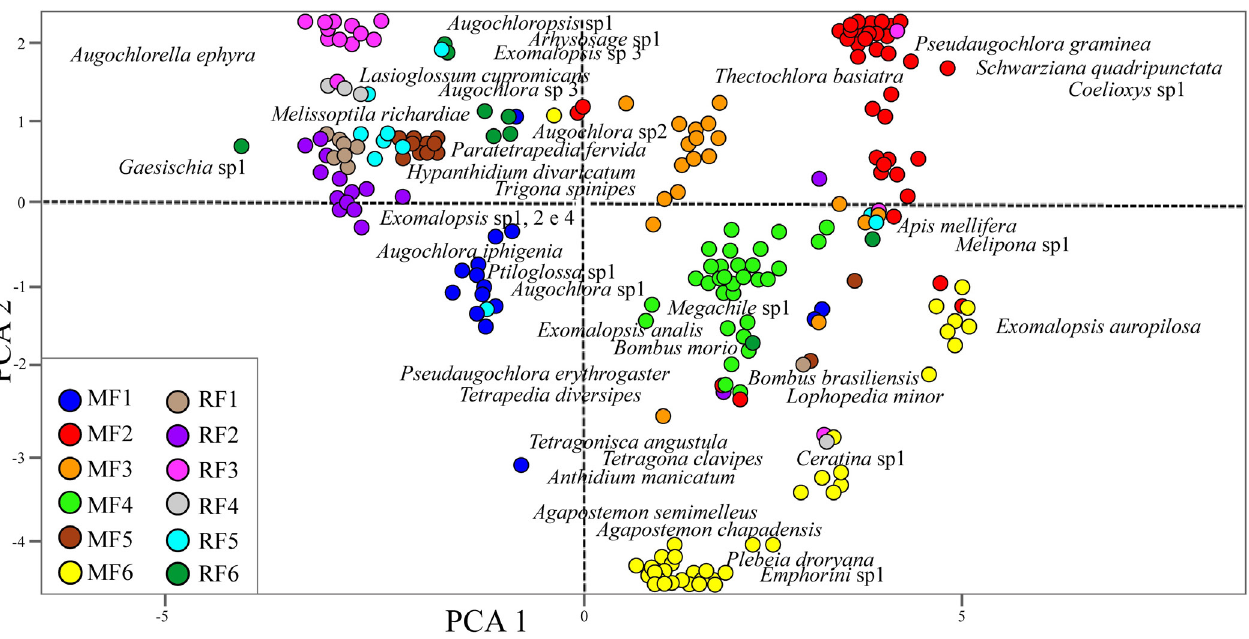
Fig 4 . Principal Component Analysis (PCA) of the bee communities at the sites (12) located in the mature (MF1, MF2, MF3, MF4, MF5 and MF6) and regenerating forest fragment (RF1, RF2, RF3, RF4, RF5 and RF6) of the Atlantic Forest, Paraná, southern Brazil.